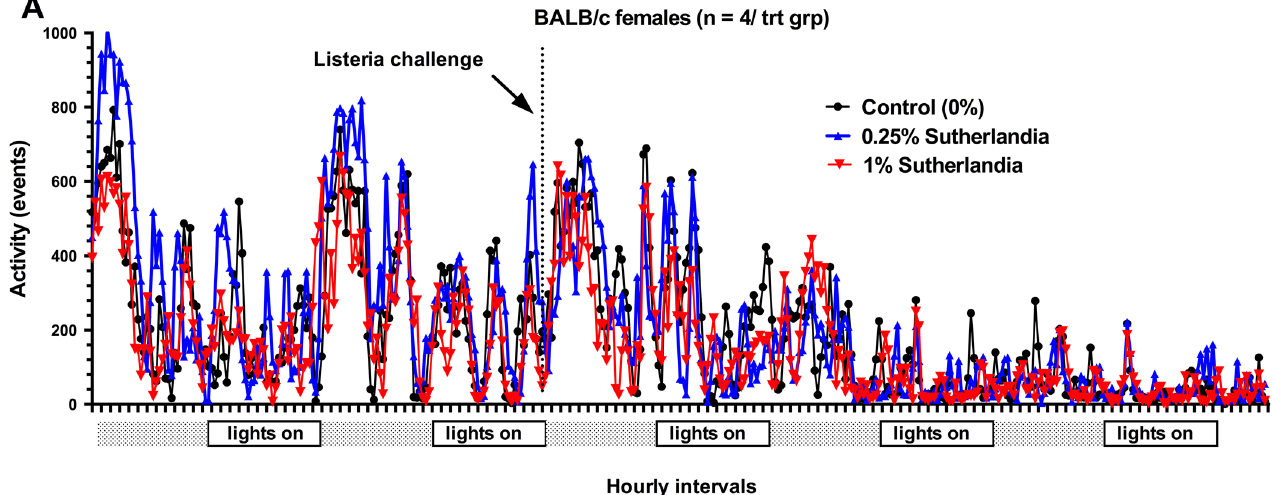
Fig 3. Dietary S . frutescens Has No Impact on Spontaneous Activity (i.e., sickness behavior) of Mice After an Experimental Infection with L . monocytogenes . Healthy female BALB/c weanling mice were fed experimental diets containing one of three doses of S . frutescens (i.e., 0, 0.25 or 1% by wt) for 3 – 4 wks. Mice were housed in pairs in a vivarium with a 12 hr light:dark cycle at a room temperature between 22 – 25°C and a relative humidity of 50 – 60% for the entirety of the study. One of each pair of mice had a mini-emitter surgically implanted under the skin along their spine between their shoulders. At ~1 week post-surgery mice received an intravenous injection of 10 4 cfu of L . monocytogenes , EGD strain. Each mouse ’ s movement/activity was recorded every 5 seconds and reported as accumulated events for every 20 minute period. Each tick mark on the X-axis represents an hour. Data shown represent the mean activity (#events) of four mice in each diet treatment group (n = 4/diet treatment group).